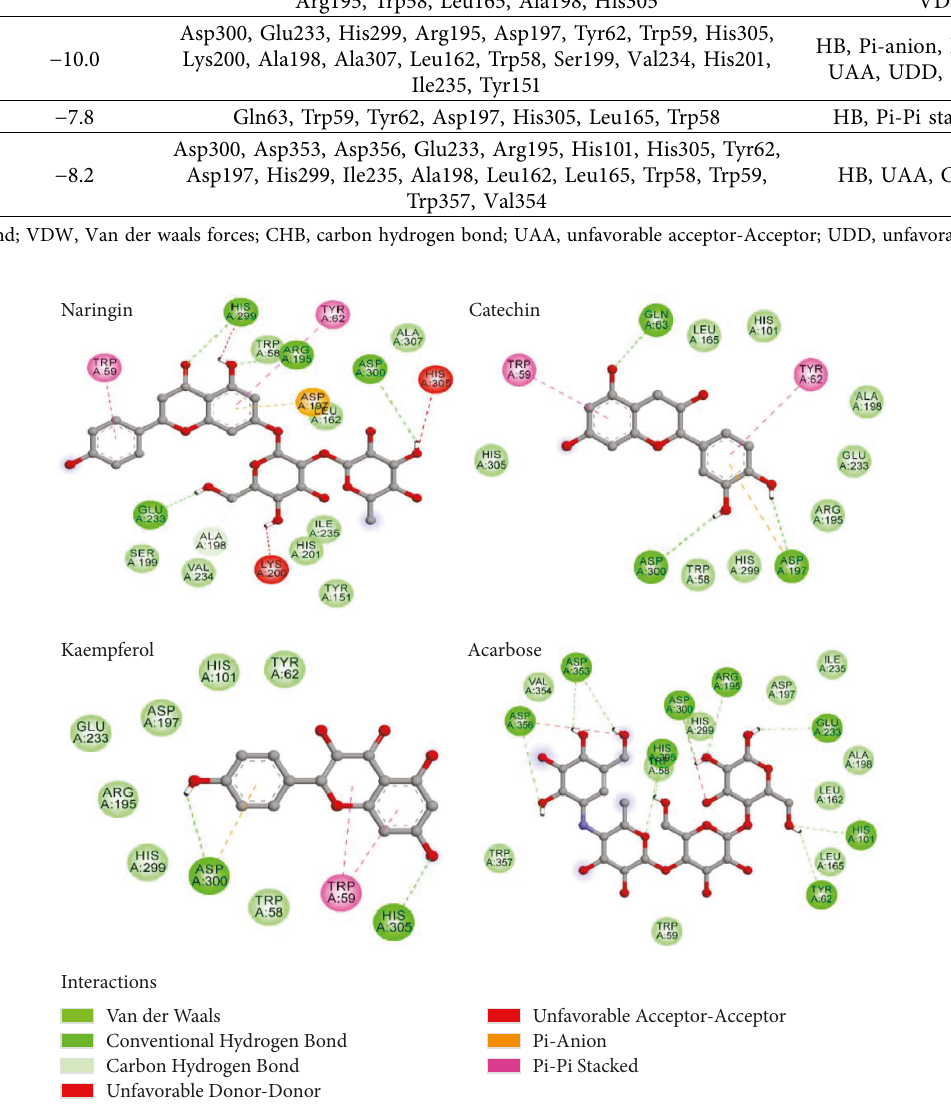
Figure 7: 2D-representations of the chemical bonding modes of the complexes formed between naringin, catechin, kaempferol, and acarbose compounds and the catalytic site residues of human pancreatic α